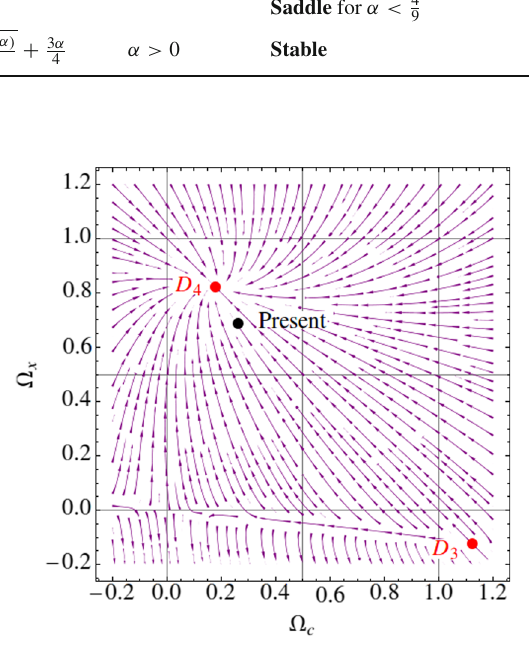
Fig. 4 Projected phase plot for model Γ 1 d with α = 0 .